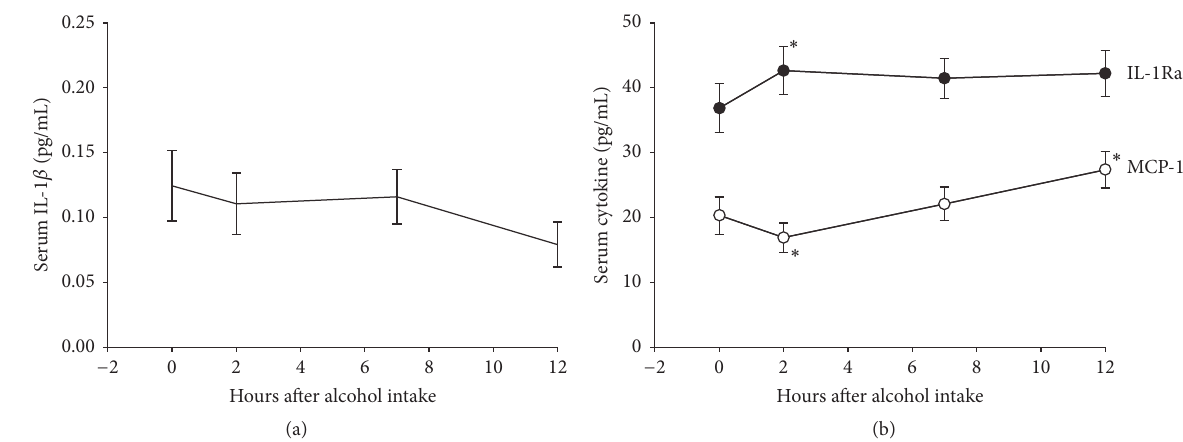
Figure 2: (a) Serum levels (mean and standard error of mean) of IL-1 𝛽 at baseline and 2, 7, and 12 hours after binge drinking of alcohol. No statistically significant trend or differences between observations were found. (b) Serum levels (mean and standard error of mean) of IL-1Ra and MCP-1 at baseline and 2, 7, and 12 hours after binge drinking of alcohol. Statistically significant changes from prebinge values were observed at T 2 for IL-1Ra and at T 2 and T 4 for MCP-1 and are indicated by an ∗ . Trend statistics were significant for both